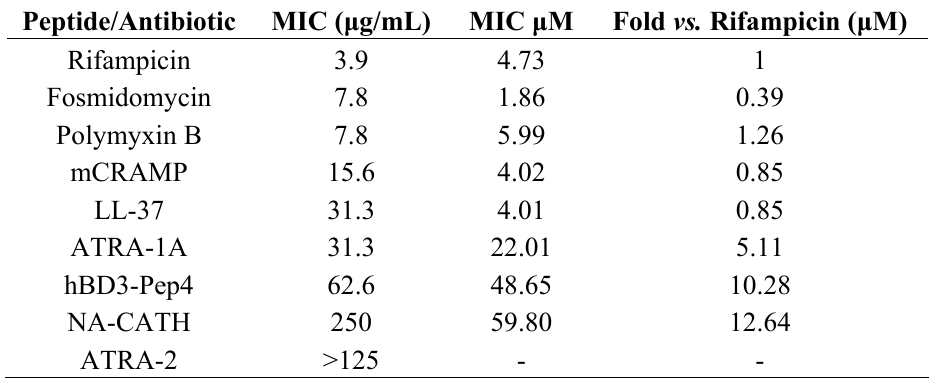
Table 3. Minimum inhibitory concentrations (MIC) of peptides against M. smegmatis